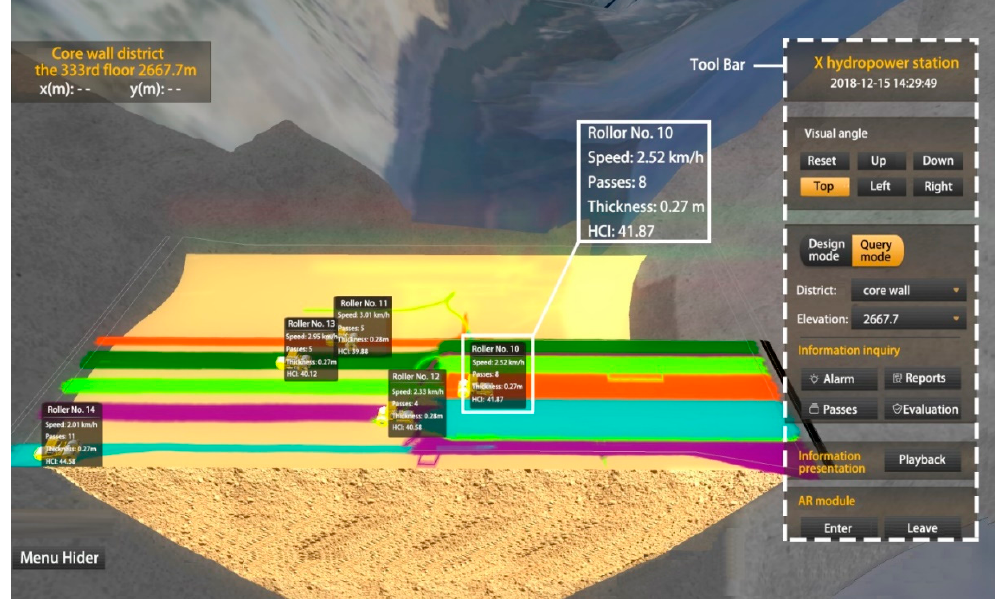
Figure 3. User interface of the 3D real-time compaction monitoring (RTCM) system.